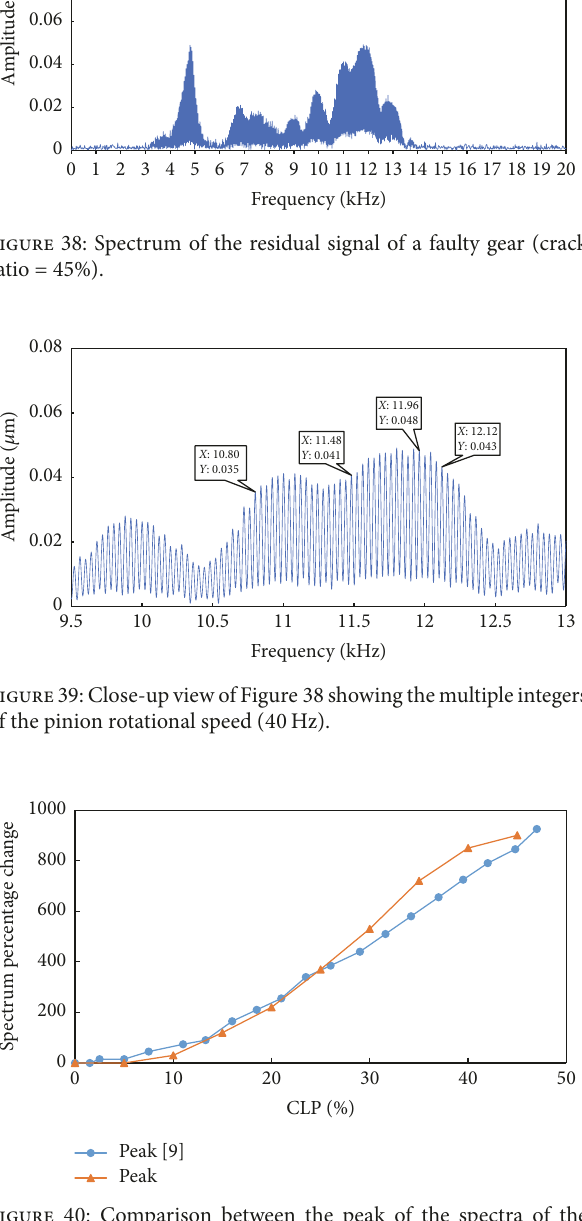
Figure 40: Comparison between the peak of the spectra of the residual signal of this study and [9] with respect to the